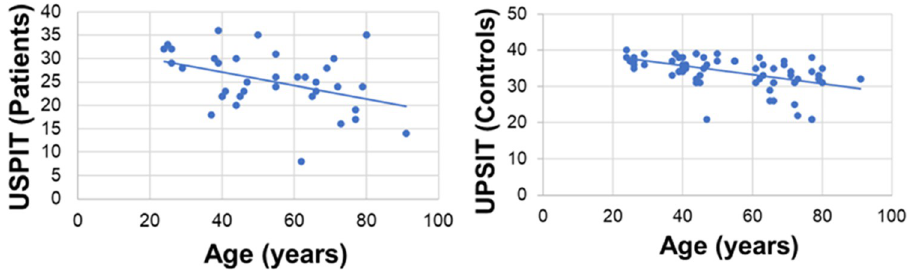
Fig 2. Scatter plot showing UPSIT based on age between the exposed individuals and control patients. Both groups show a negative correlation (Rho = -0.36, p = 0.032 and Rho = -0.56, p < 0.001, respectively). Rho: Spearman ´s correlation